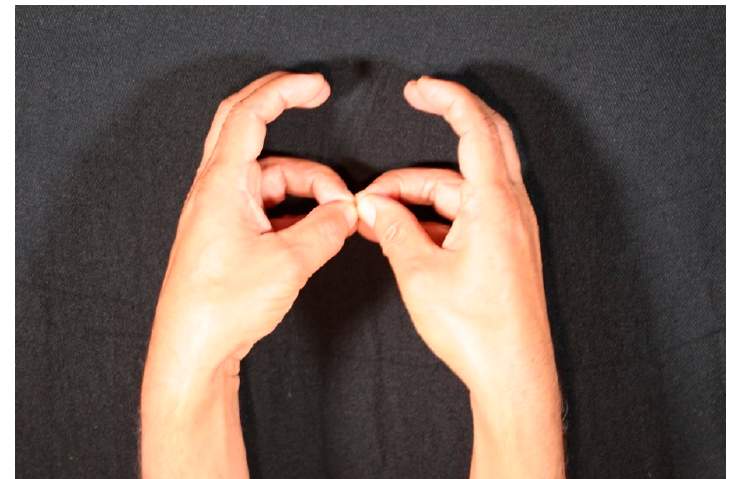
Figure 1. Ā kar ṣ i ṇ ī -Mudr ā . Figure 1. ¯Akars.in.¯ı-Mudr¯a.